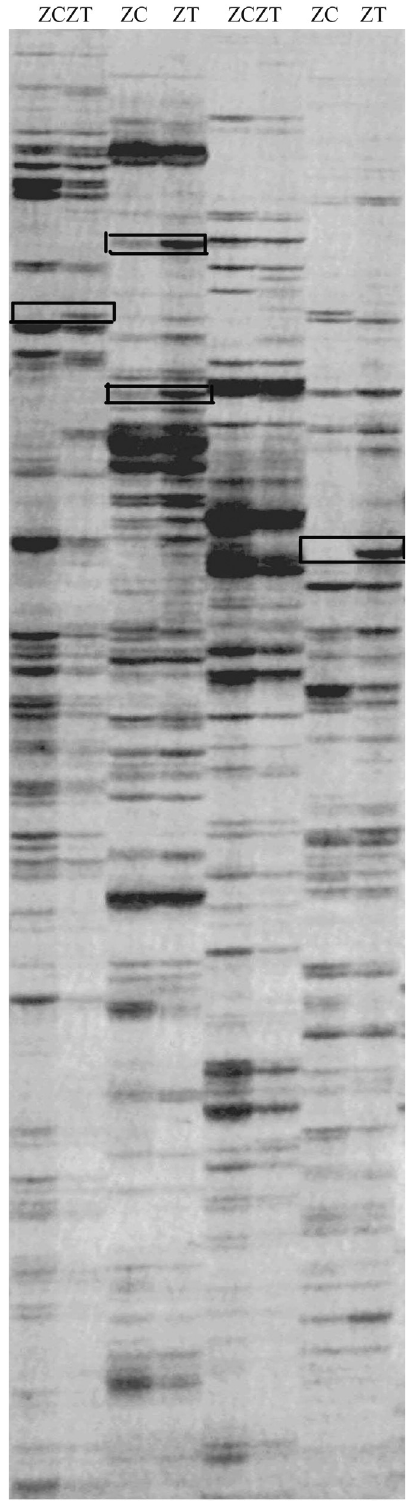
Figure 1 - cDNA-AFLP autoradiogram of four of the most informa- tive-primer combinations that amplified differentially expressed genes in flower buds and sprout-shoot apical meristems. The codes for the primers used in the combinations are shown shown in Table S1, The boxes empha- size differential-expressed fragments. (ZT: flower bud, ZC: sprout-shoot apical